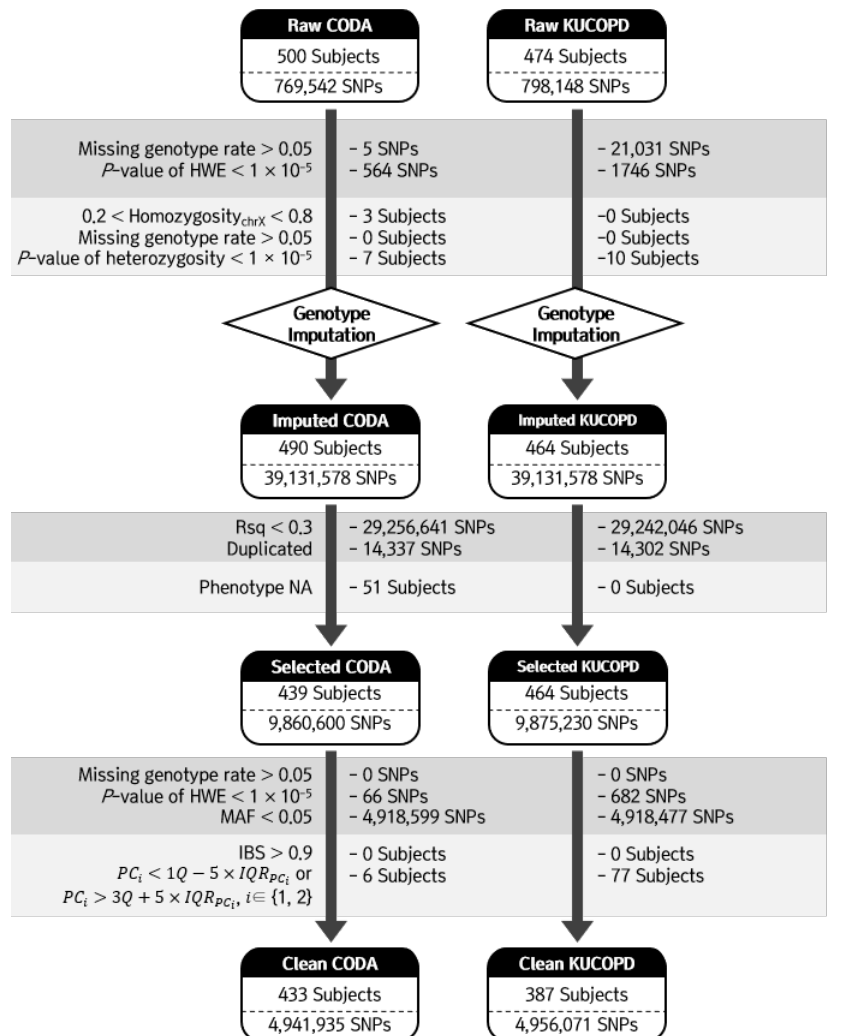
Figure 1. Workflow of quality control for CODA and KUCOPD data. Several standard quality control steps were produced for CODA and KUCOPD data to exclude outlier single-nucleotide polymorphisms (SNPs) and subjects.